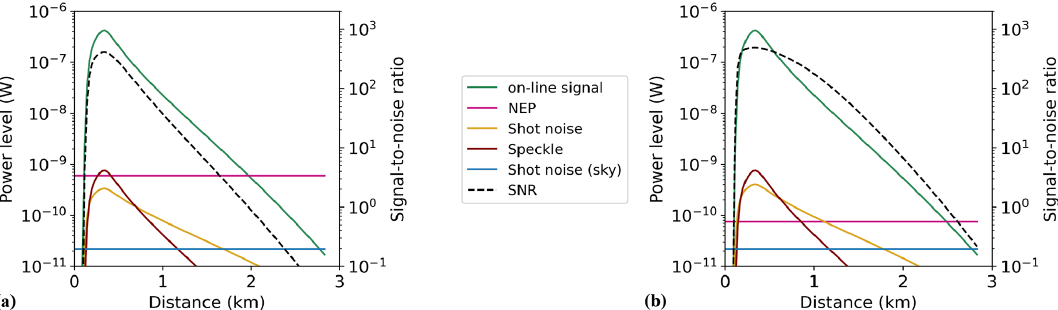
Figure 4. Received power according to Eq. (2) (solid green line) and power-equivalent levels of major noise contributions related to the H 2 O on-line signal for a single 20mJ pulse and resulting signal-to-noise ratio (SNR, dashed black line, right vertical axis) as function of lidar